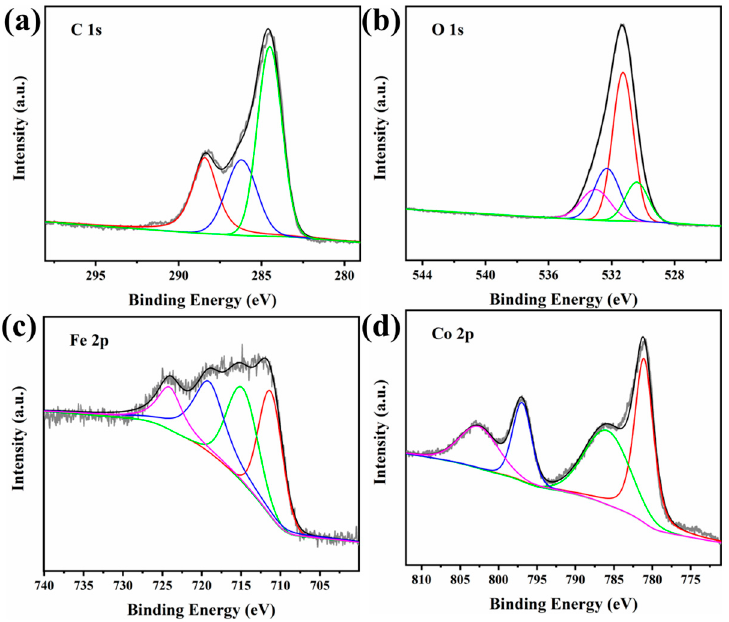
Figure 3. XPS spectra of Co(OH) 2 @TA ‐ Fe: C 1s ( a ), O 1s ( b ), Fe 2p ( c ) and Co 2p ( d ).